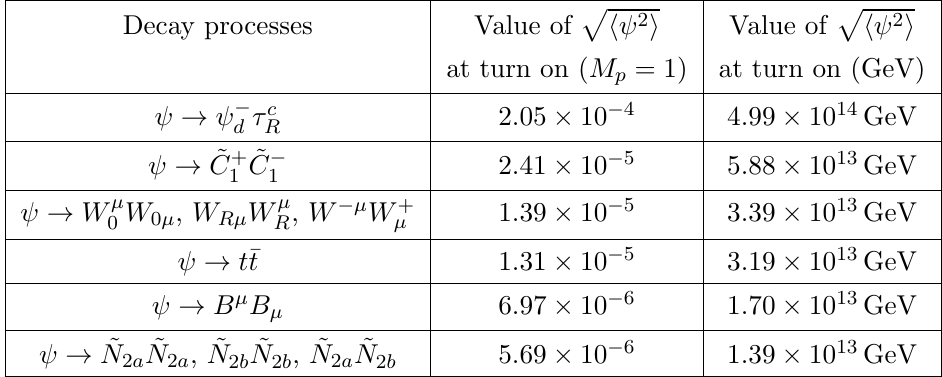
Figure 12. The rates (cid:0) d;i for di(cid:11)erent decay processes plotted with respect to couplings are all evaluated at the reheating scale of 5 : 8 (cid:2) 10 13 GeV. Since time,